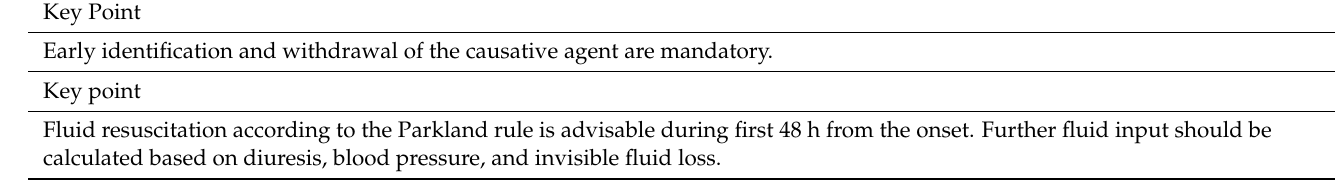
Table 3. Key points for symptomatic